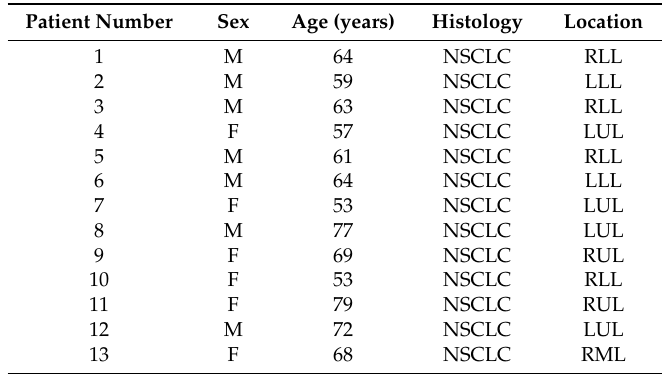
Table 1. Clinical features of patients with non-small cell lung cancer